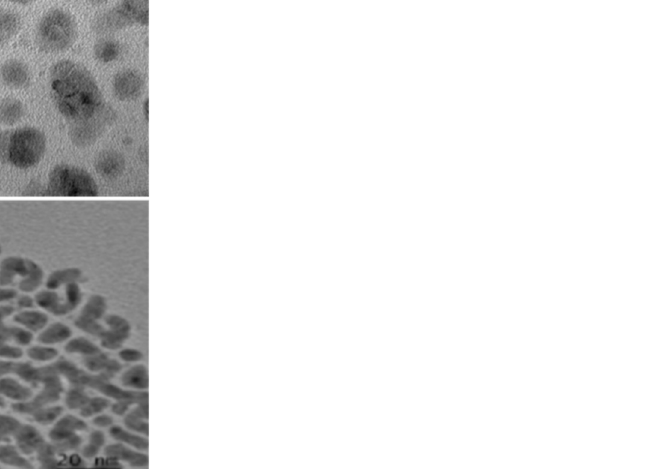
Figure 7. Transmission electron microscopy (TEM) images of Ag ( a ) and Au ( b ) nanoparticles.